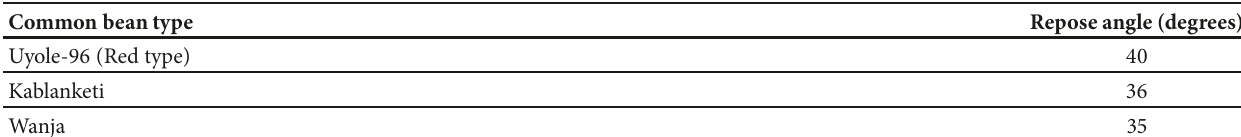
Table 7: Angle of repose results.